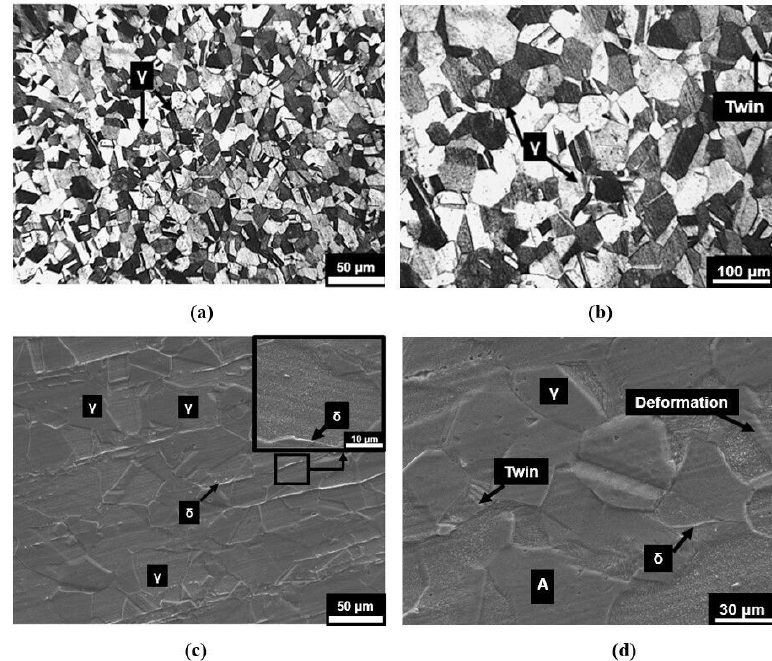
Figure 3. Micrographs were obtained from the cold rolled 316L stainless steel in direction ND. (a-b) by OM; (c-d) by